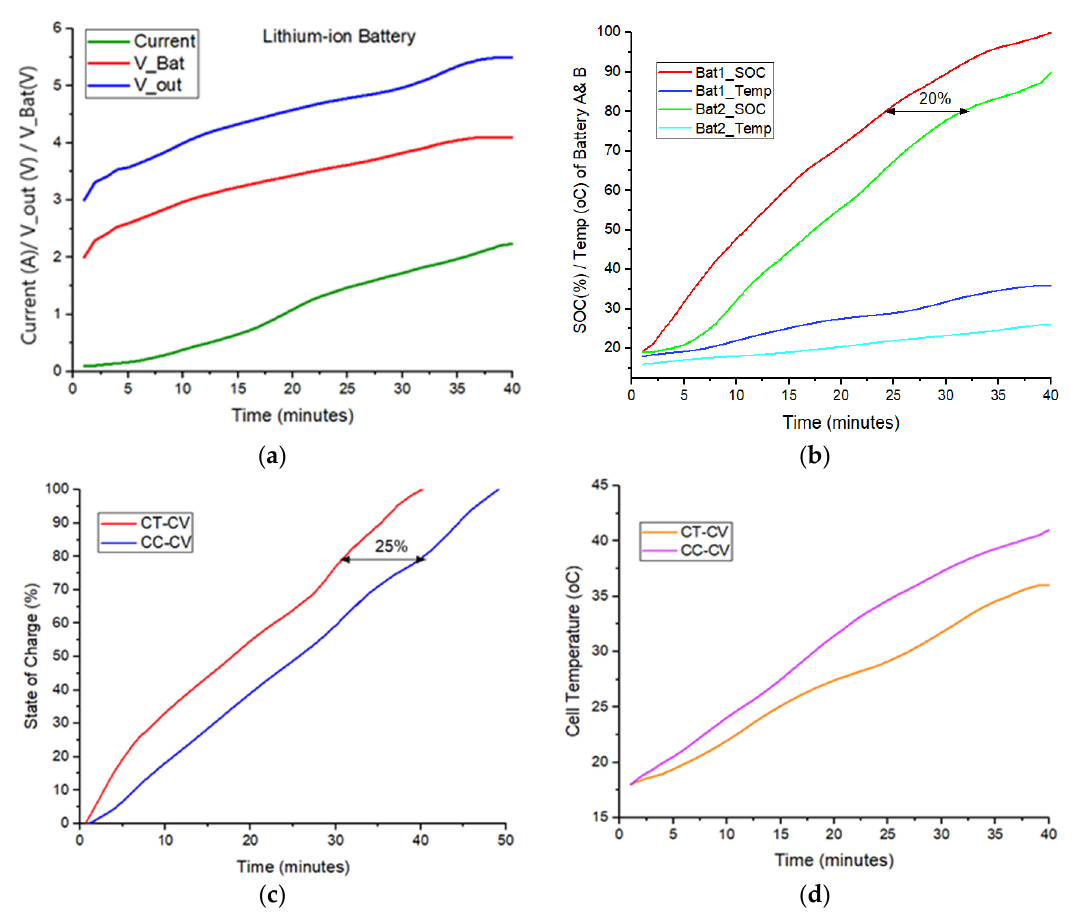
Figure 6. Experimental results showing the charging profile of the Li-ion battery cell: ( a , b ) depicts the comparison of proposed method with reference battery. CT–CV achieves 20% faster charging than reference battery; ( c , d ) indicates the comparison of CC–CV and CT–CV methods. CT–CV charges 80% cell in 30 min, while CC–CV charges in 40 min. Thus, 25% faster charging is